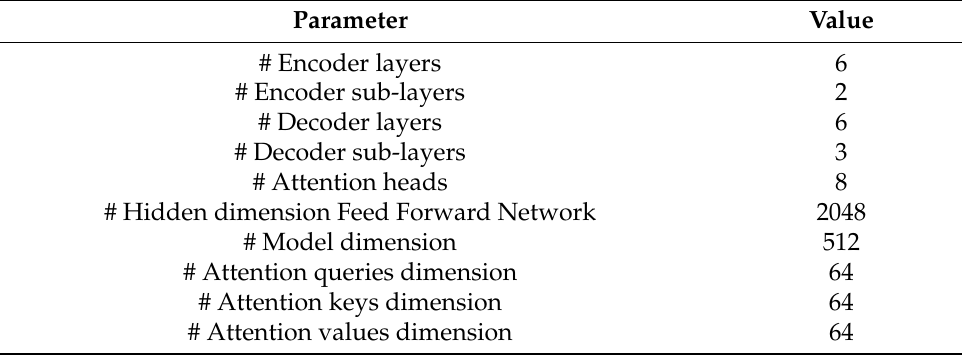
Table 1. Selected parameters of the model based on TNN. Parameter Value # Encoder layers